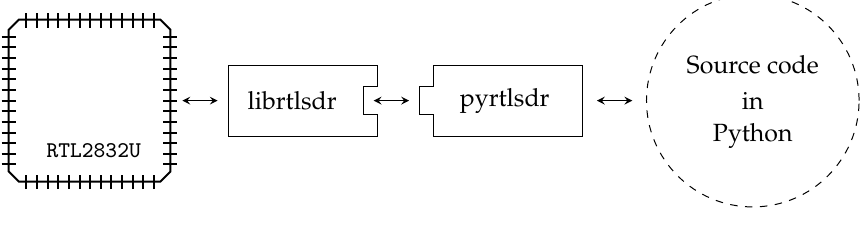
Figure 13. Communication between the digital video broadcasting-terrestrial (DVB-T) dongle and the single board computer (SBC). The RSL2832U chip-set is interfaced by the library librtlsdr. The wrapper pyrtlsdr provides convenient access to the library function. Both, librtlsdr and pyrtlsdr run on the